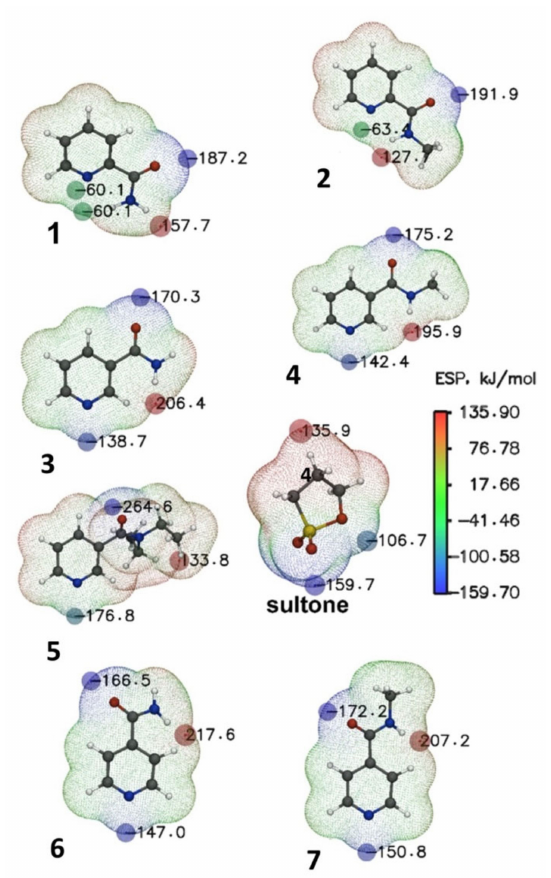
Figure 6. ESP (kJ mol − 1 ) mapped molecular vdW surface of nucleophilic addition reaction reagents 1 – 7 . The surface local minima and maxima of ESP are represented as blue and red spheres, respectively. The local surface maxima with negative ESP values are meaningless and are thus not shown. Only the global minimum and maximum are